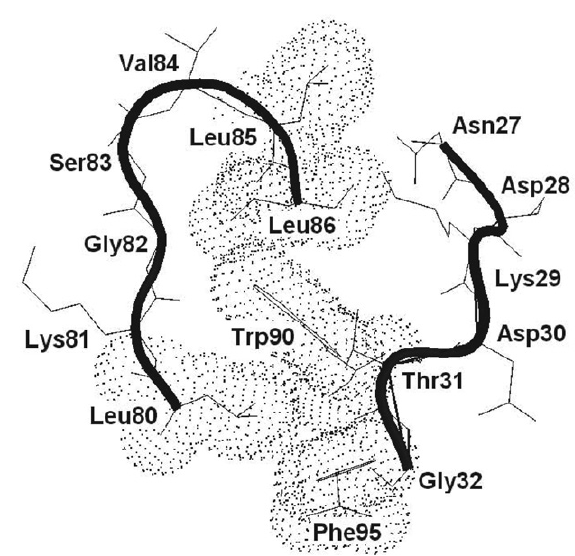
Figure 1. The binding site of hCoV-OC43 S (PDB ID: 6NZK) con- sists of two loops, L1 (27-Asn-Asp-Lys-Asp-Thr-Gly-32) and L2 (80-Leu-Lys-Gly-Ser-Val-Leu-Leu-86), and two hydrophobic pock- ets, P1 (Leu85, Leu86 and Trp90) and P2 (Leu80, Trp90 and Phe95) given by